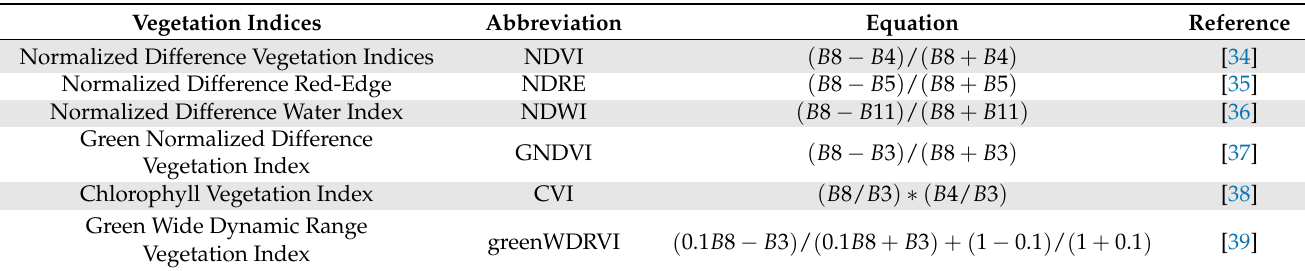
Table 1. Vegetation indices adopted for crop